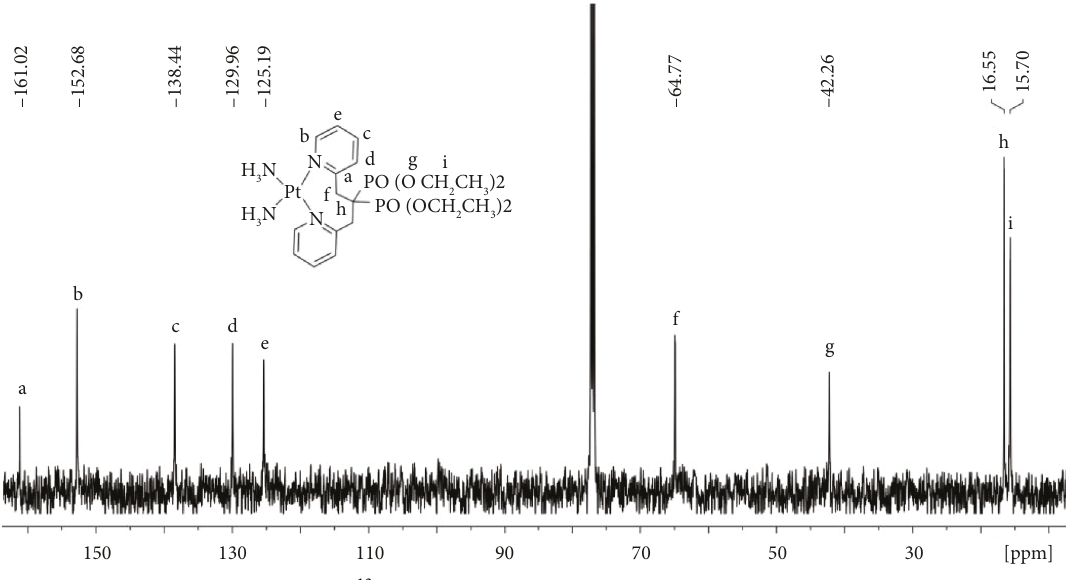
Figure 5: 13 C-NMR (125MHz, CDCl